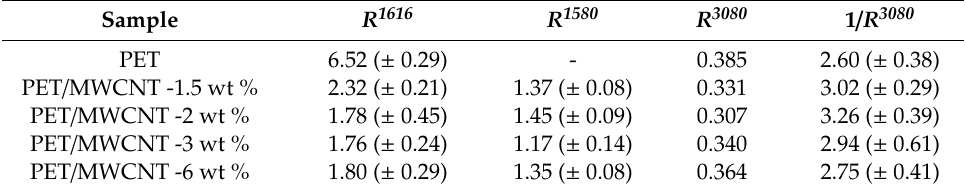
Table 3. Polarization ratio values obtained from polarized Raman spectroscopy measurements for PET and PET / MWCNTs composite films stretched to a draw ratio of 4.